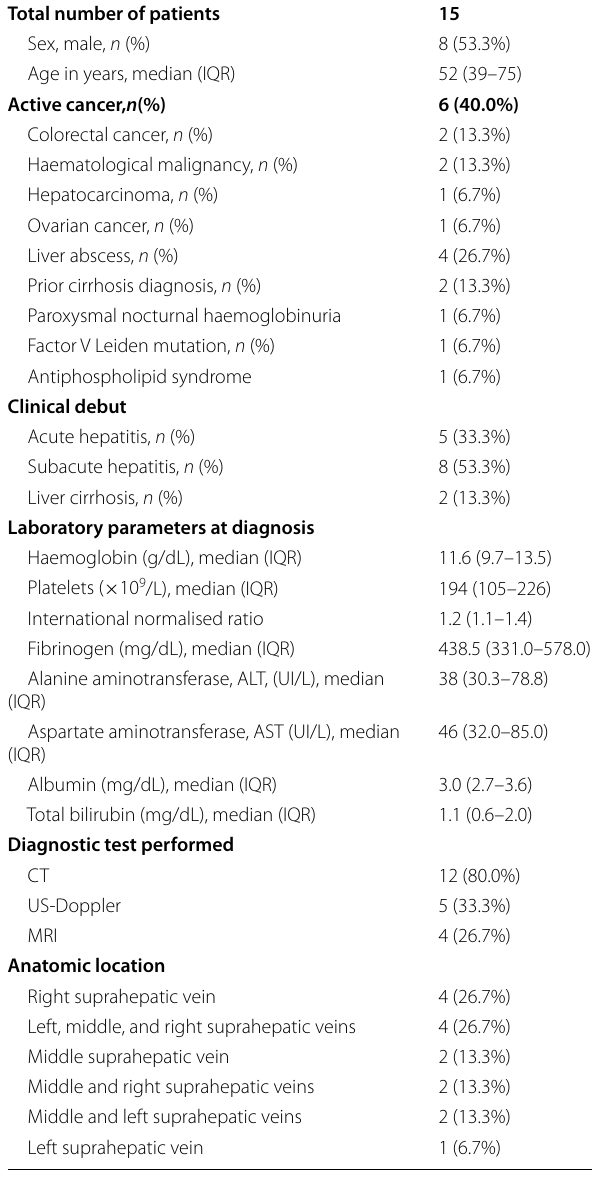
Table 1 Risk factors and clinical characteristics of the study population